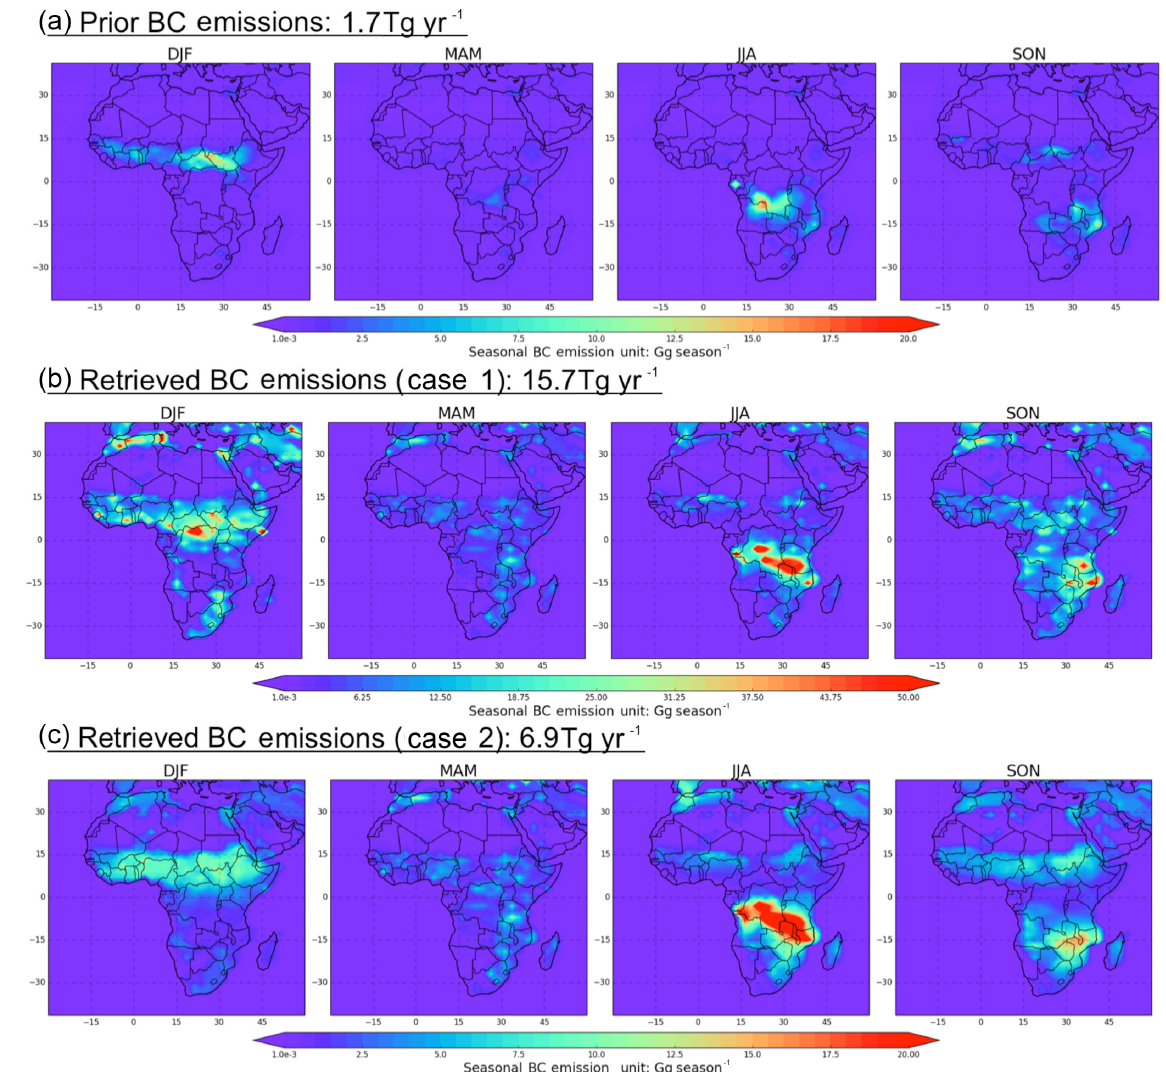
Figure 15. Spatial distribution of seasonal BC emissions: (a) prior model BC emissions from GFED3 and Bond inventories; (b) Case 1 retrieved BC emissions; (c) Case 2 retrieved BC emissions. Note that the colour scale for (b) is different from (a) and (c) for better resolving the spatial